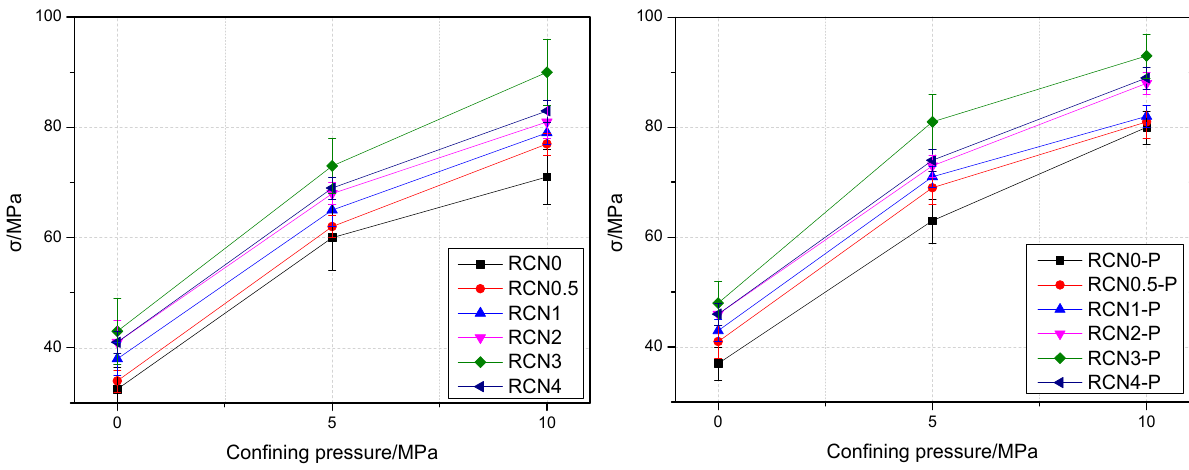
Figure 6. Relationship curve between confining pressure and peak stress.